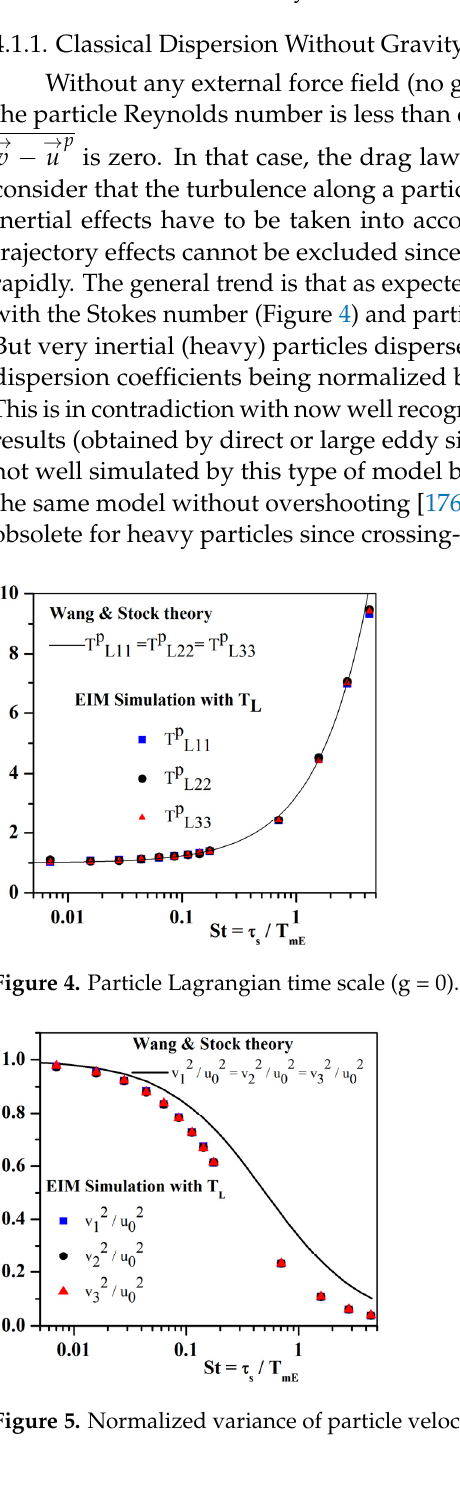
Figure 6. Particle dispersion coefficient (g = 0). 4.1.2. Modified EIM with Wang and Stock Correction (No Gravity) A similar simulation but with Wang and Stock’s relation (Equation (A1) in Appendix A) gave much more promising results for the turbulent energies (Figure 7). In particular, Figure 8 indicates that the ratio of the particle dispersion coefficient to the fluid diffusivity is greater than unity for the large Stokes number; this result is in accordance with the theories of Reeks [40] or Pismen and Nir [57], with the experimental observations of Wells and Stock [16], with the direct numerical simulation of Squires and Eaton [98] and with the large eddy simulation of Deutsch [178]. Only for large Stokes numbers are the particle